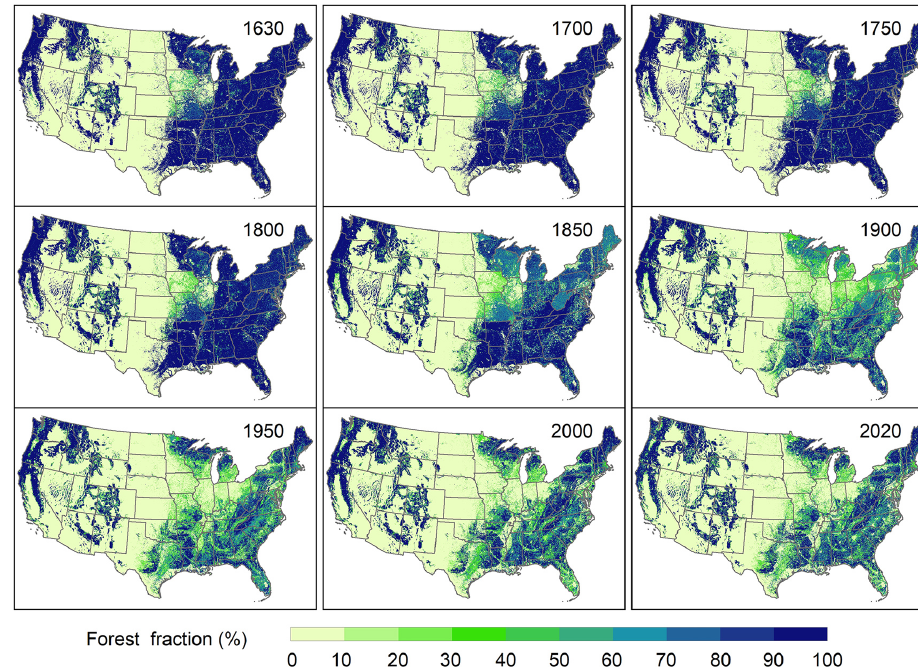
Figure A5. Fractional area of forest in the conterminous United States during 1630–2020.